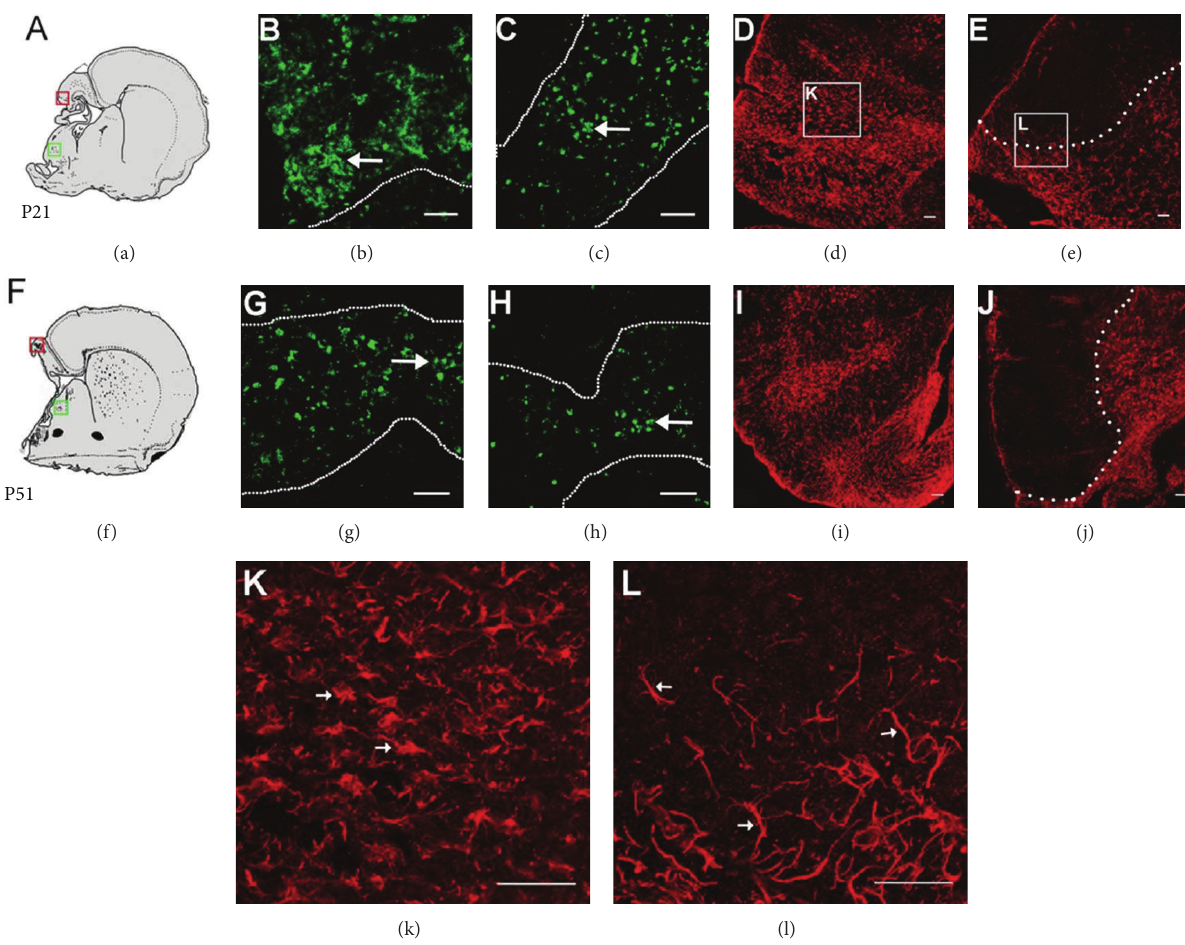
Figure 5: Reduction of microglial infiltration and GFAP expression after hUCB transplantation (see [25]). Schematic drawings show representative coronal brain sections after hypoxic-ischemic lesion corresponding to Bregma þ 1.2-( þ ) 0.2 mm at P21 (a) and P51 (f). Boxes highlight photographed areas (green: CD68 expression in the basal ganglia; red: GFAP expression in the cortex). (b) HI led to an infiltration of CD68 positive microglia. Cells were present at the lesion site throughout the late acute ischemic (P21) and, to a lesser extent, in the chronic postischemic phase ((g) P51). Dotted lines delineate histological defined areas of prominent tissue damage, and these express higher levels of CD68. Long white arrows indicate clusters of CD68 positive cells. Brains of transplanted animals showed a reduced microglial infiltration at both time points compared to nontransplanted animals ((c) P21; (h) P51). In analogy, two weeks following HI a massive upregulation of GFAP encircling the lesion site was observed (d) and maintained until seven weeks of age (i). hUCB transplantation led to a reduced amount of GFAP immunoreactivity around the ischemic zone ((e) P21; (j) P51), thus leaving a larger portion of the remaining cortex spare of the inflammatory reaction ((e) and (j) white dotted line indicates border of cortical areas with lower versus those with higher GFAP expression). Astrocytes in the vicinity of the ischemic zone presented an activated phenotype characterized by a large soma and fewer processes, thus obtaining a more rounded shape ((k) white arrows). In hUCB transplanted animals, a higher number of astrocytes appeared to have a more elongated phenotype with long processes ((l) white arrows). Scale bars: 50 𝜇 m. (For interpretation of the references to color in this figure legend, the reader is referred to the web version of this paper.) This paper is available online at: